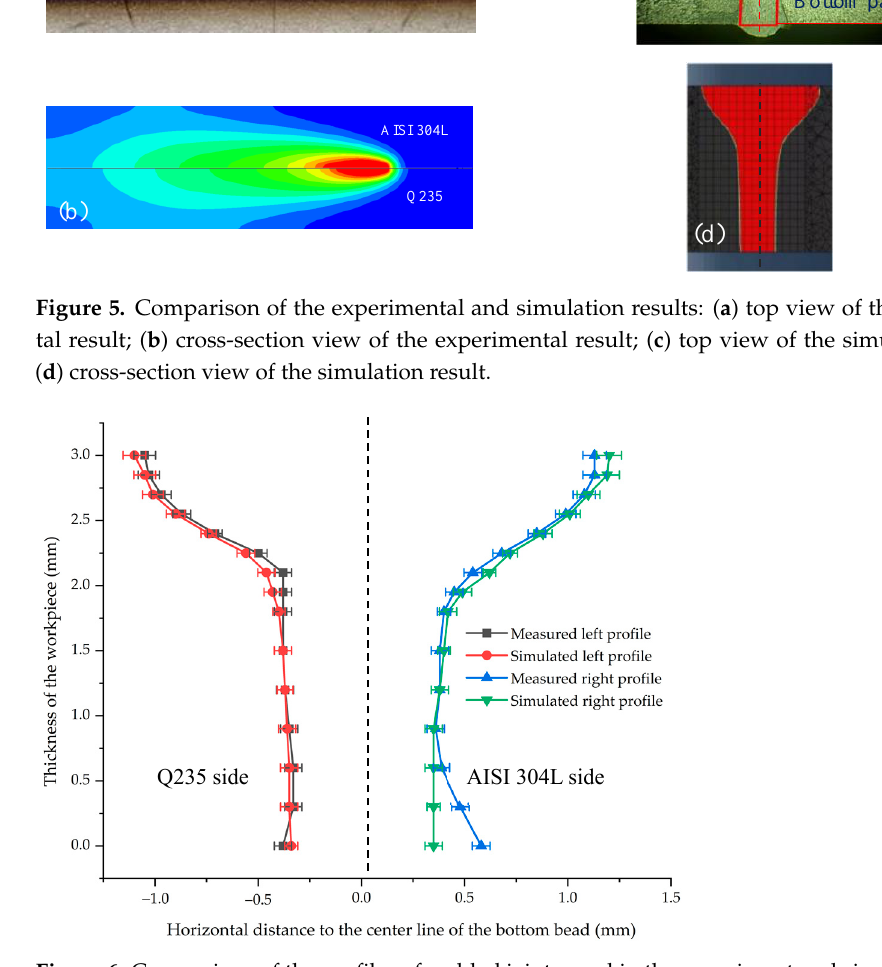
Figure 6. Comparison of the profiles of welded joints used in the experiment and simulation.